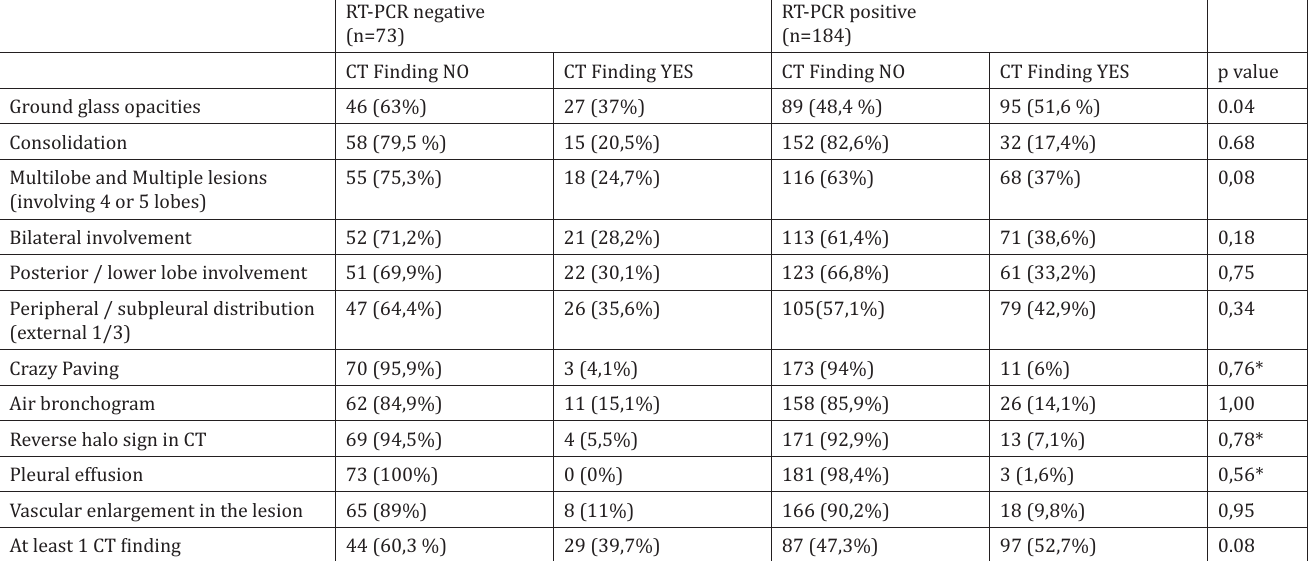
CT Imaging findings in 257 patients diagnosed COVID-19 with RT-PCR.